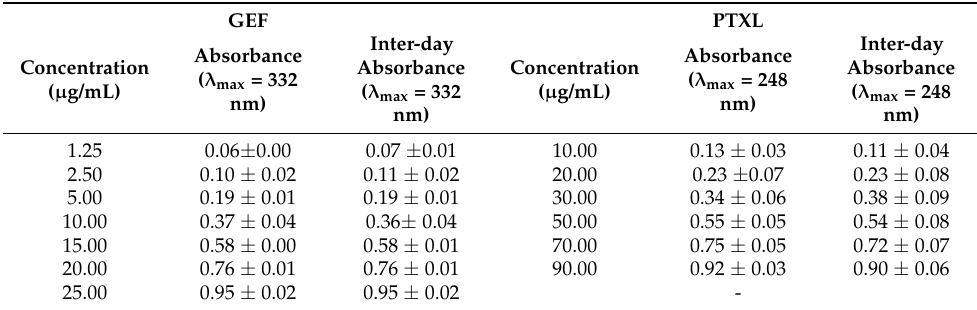
Table A1. Absorbance and inter-day absorbances of GEF and PTXL at various concentrations. Absorbances are expressed as mean ± SD.